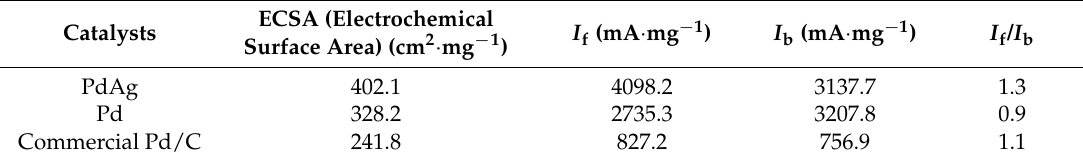
Table 1. Comparison of properties among the as-prepared